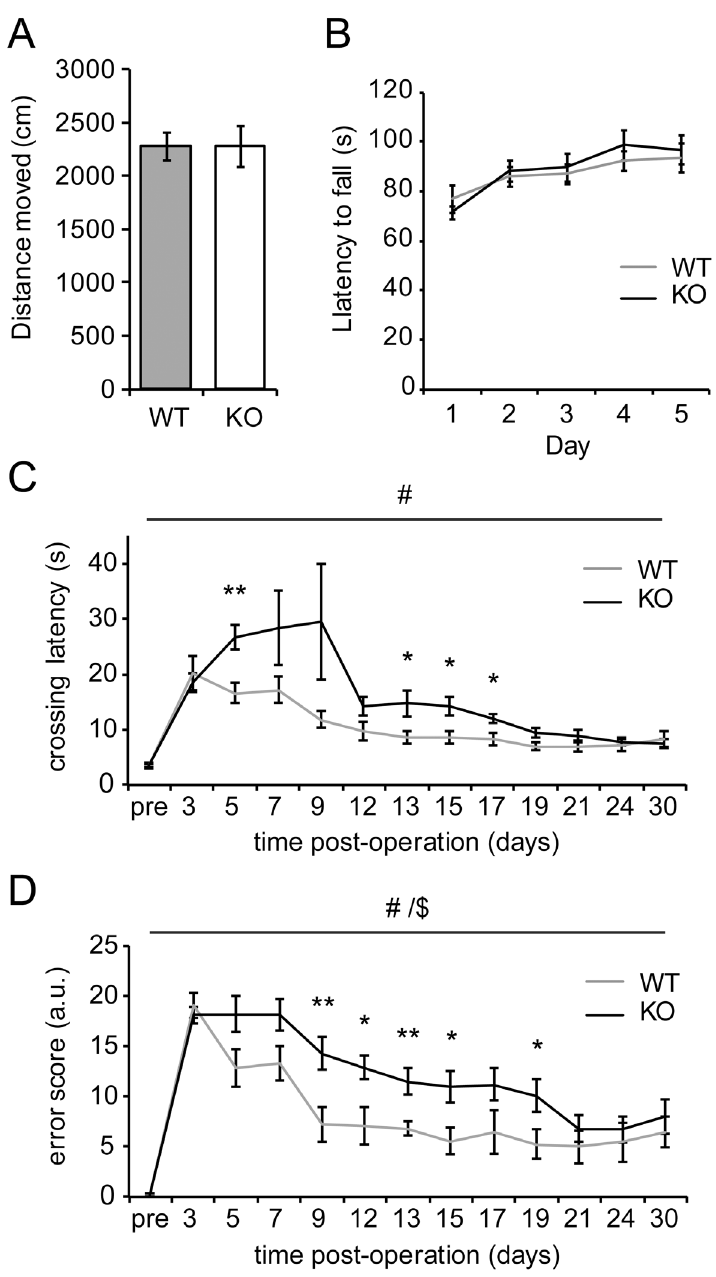
Fig 3. Nfil3 deletion impairs functional recovery from peripheral nerve injury in vivo . (a) Nfil3 KO mice show no differences in the total distance moved in the open field task (n = 12, t (22) = -0.27, p = 0.98). (b) The latency to fall off an accelerating rotarod was not affected in Nfil3 KO mice (n = 12, F (1,22) = 1.02, p = 0.32). (c) Nfil3 KO mice have a significantly longer beam crossing latency than wildtype mice (main effect genotype, n = 11/10, F (1,19) = 8.893, # p = 0.008). Post-hoc t-tests indicated indicate significant differences in performance at post-lesion days 5, 13, 15 and 17 ( ** p < 0.01, * p < 0.05). (d) Nfil3 KO mice also make significantly more errors when crossing the beam (main effect genotype, n = 11/10, F (1,19) = 7.145, # p = 0.015; interaction genotype * time, F $ p = 0.016). Post-hoc t-tests indicate significant (12,228) = 2.131, differences in performance at post-lesion days 9, 12, 13, 15 and 19 ( ** p < 0.01, * p < 0.05).